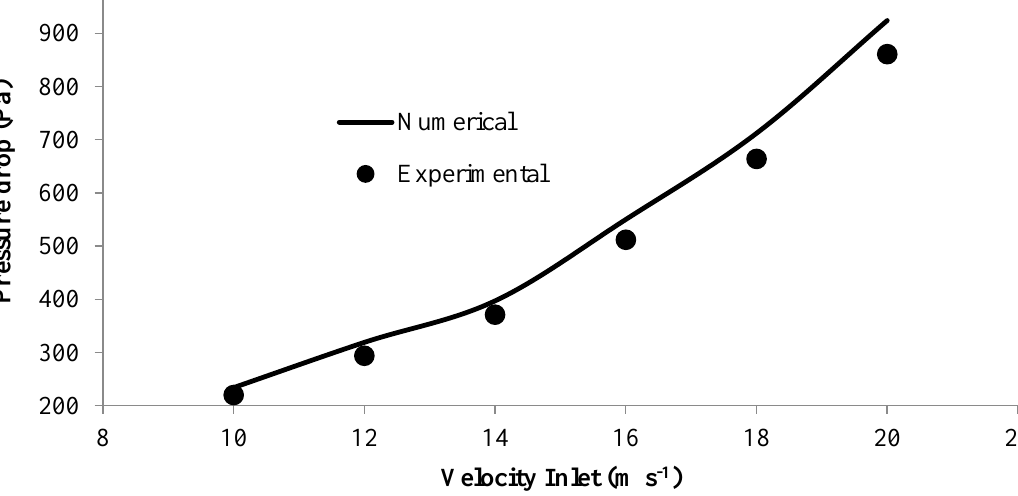
Figure 4. Validation between numerical results and experimental data for pressure drop.